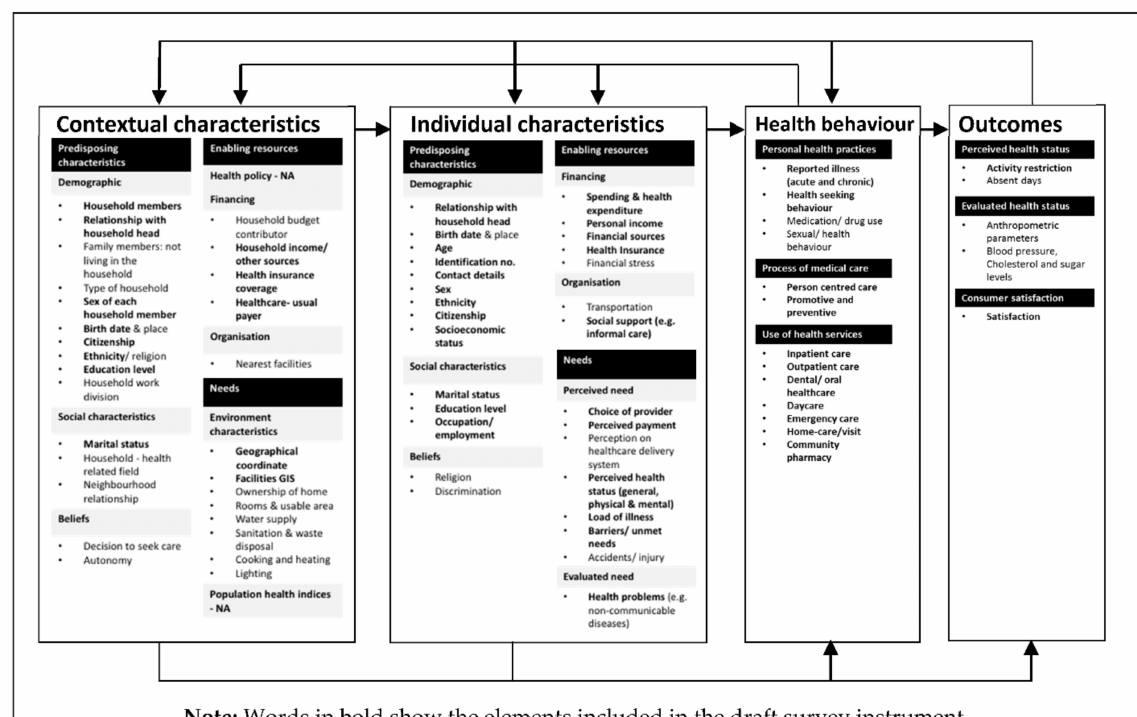
Figure 2. Domains mapping based on Andersen’s Behavioural Model of Health Services